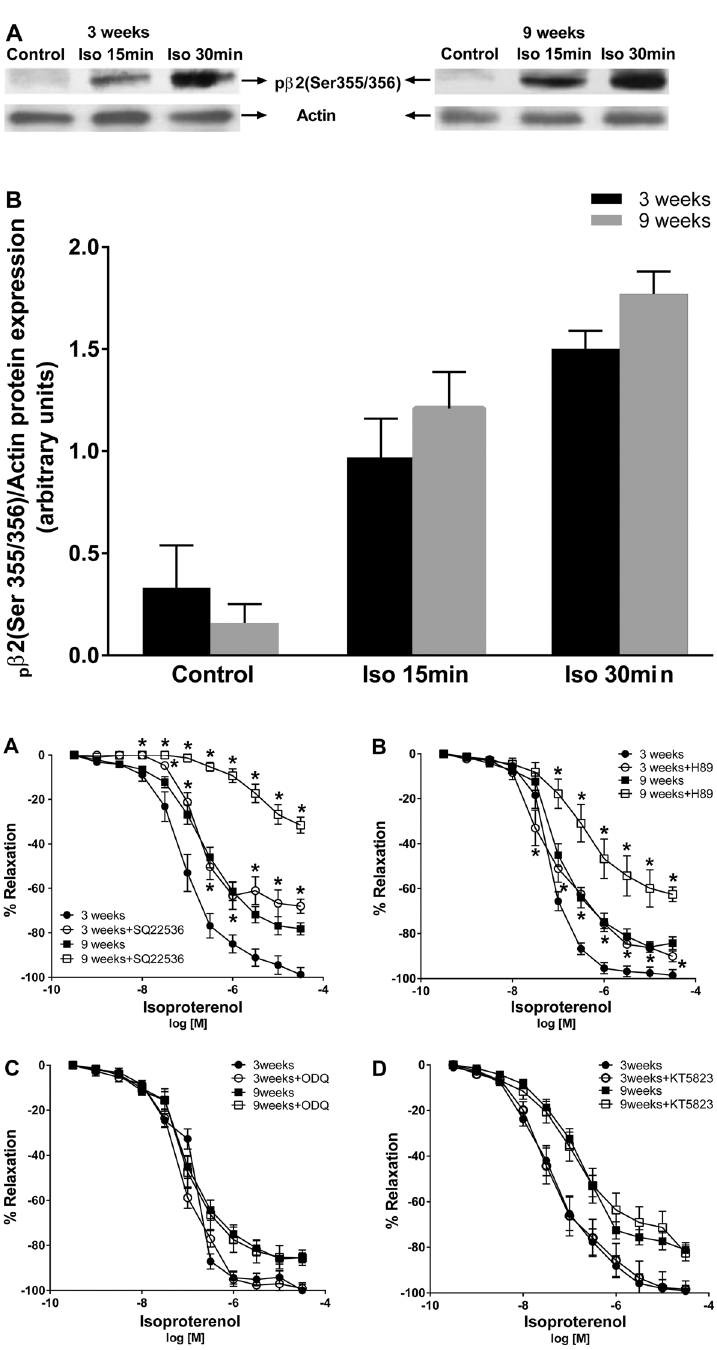
(Figure 6A and B). The guanylyl cyclase inhibitor ODQ and the PGK inhibitor KT75823 did not affect isoproterenol- induced relaxation in aortic rings of younger and older rats (Figure 6C and D). cAMP production by aortic rings was measured after stimulation with isoproterenol. The results indicated that